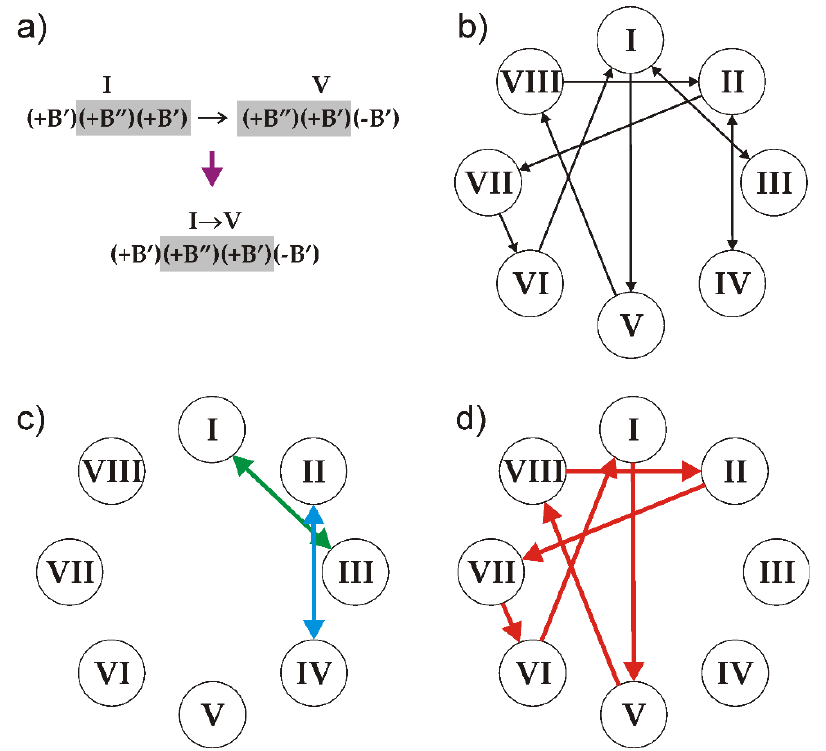
Figure 11. An illustration of the rule of overlapping triplets using the example of the I – V pair ( a ), the diagram of relations between the triplets ( b ) and the parts of the diagram that result in the generation of clinokurchatovite ( c ) and kurchatovite ( d ) structures. See the text for details. After [33].